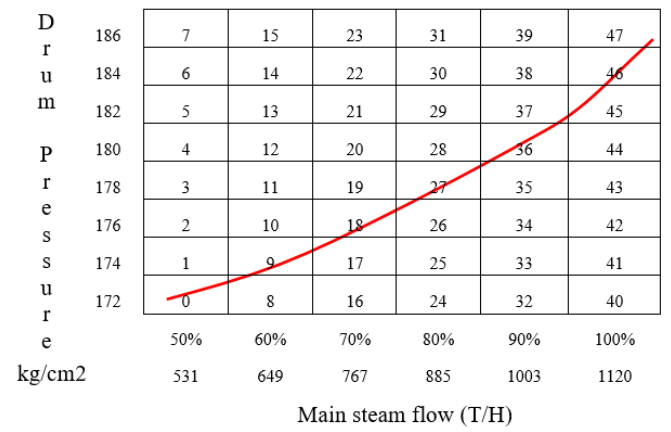
Figure 11. Recommended operation curve for a Heat Recovery Steam Generator.